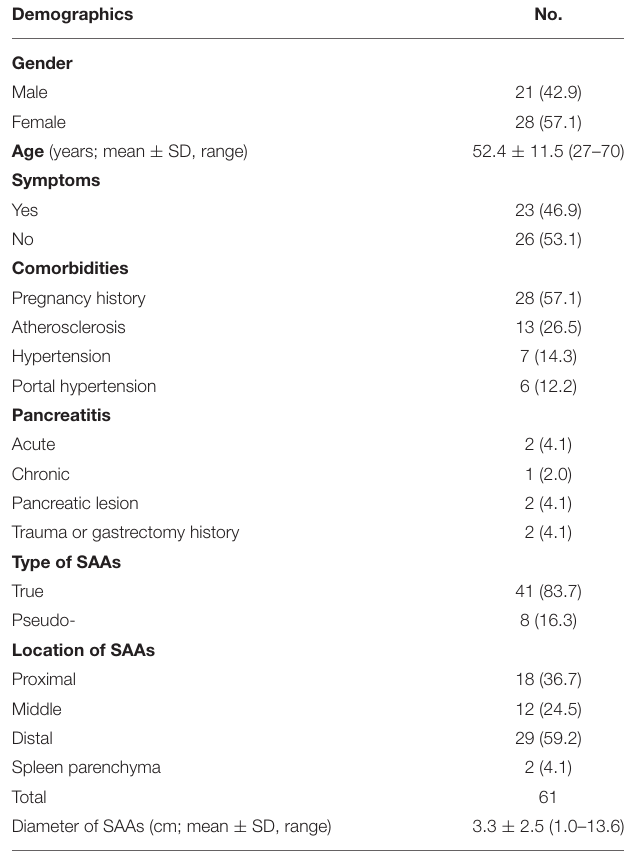
TABLE 1 | Baseline characteristics of patients and splenic artery aneurysms